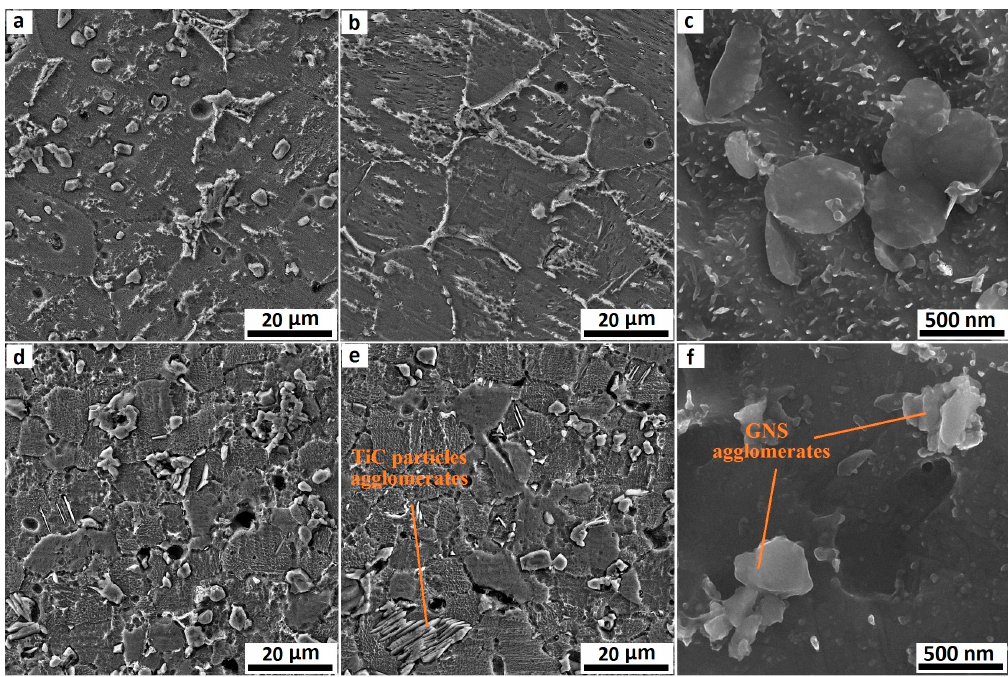
Figure 6. SEM image of Ti/GNS composite containing 1 and 1.5 wt. % of GNSs, ( a ) Ti/1GNS composite sintered for 1 h, ( b , c ) Ti/1GNSs composite sintered for 5 h, ( d ) Ti/1.5GNSs composite sintered for 1 h, and ( e , f ) Ti/1.5GNSs composite sintered for 5 h.